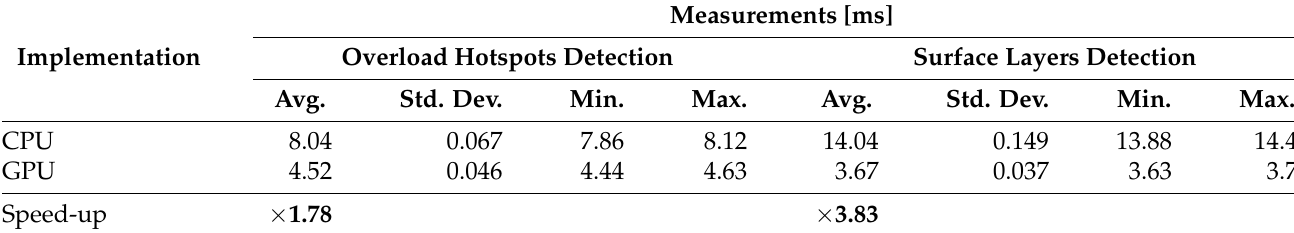
Table 2. Performance of the thermal event detection algorithms.